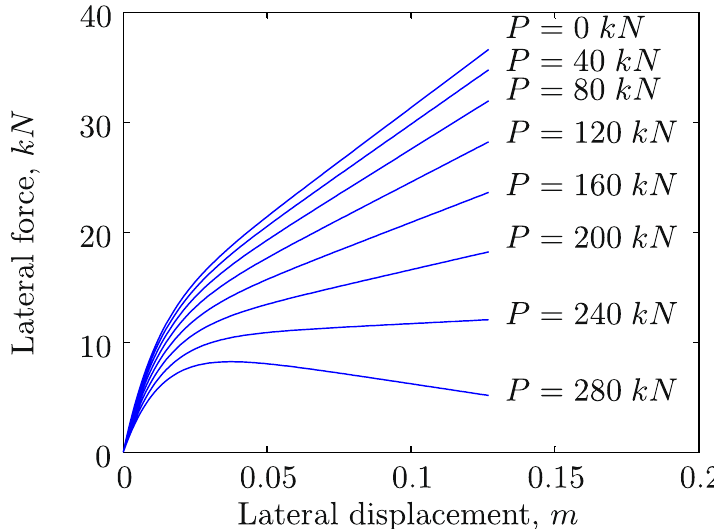
Fig. 6 Lateral force-lateral displacement trends under different compressive